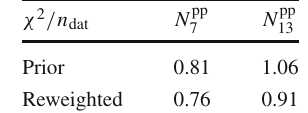
Table 3 Values of χ 2 / n dat for the LHCb D -meson measurements of N pp before and after